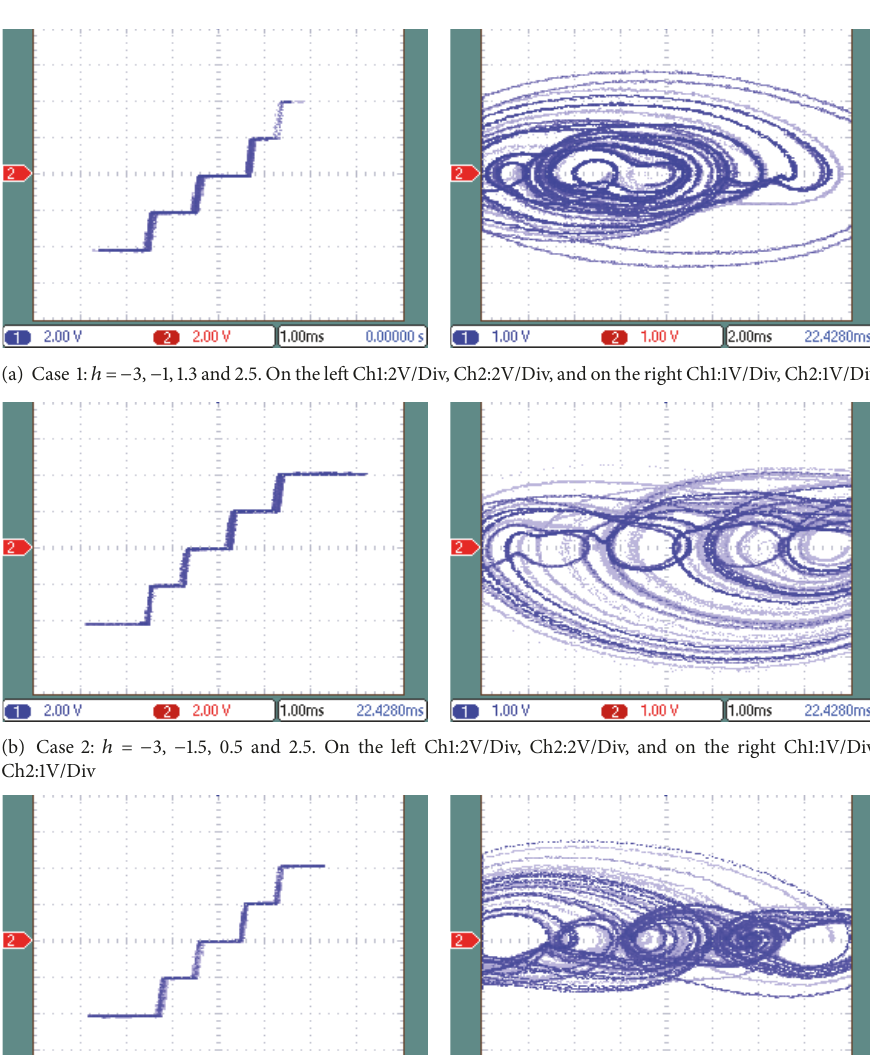
Figure 12: Experimental verification of optimized 5 scrolls using irregular SNLFs with different delays given in Table 5.